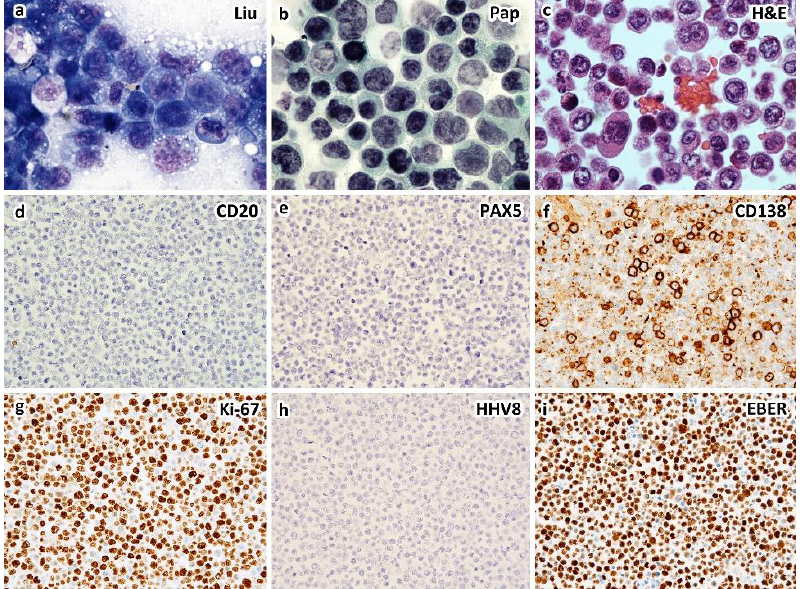
Figure 2 . An example of HIV-unrelated, HHV8-negative (type II) PEL of plasmablastic type in a 61-year-old man who presented with left pleural effusion and ascites without solid tumor by CT scans. Cytological smears of the left pleural effusion and ascites show similar features of large, atypical lymphocytes with anaplastic morphology and intracytoplasmic vacuoles by Liu stain ( a ) and Papanicolaou stain ( b ). Cell block section shows large, atypical lymphocytes with occasional Hodgkin/Reed– Sternberg-like cells (( c ), H&E stain). Immunohistochemically, the atypical lymphocytes express CD138 ( f ), EMA and IRF4/MUM1, but not CD3, CD19, CD20 ( d ), CD30, CD45, CD56, CD79a, PAX5 ( e ), HHV8-LANA1 ( h ), kappa, or lambda light chains. Ki-67 proliferation index is greater than 90% ( g ). EBER in situ hybridization is positive ( i ). Interphase fluorescence in situ hybridization reveals rearrangements of BCL2 and MYC, but not BCL6. Serum HIV assay is negative (( a – c ), × 1000; ( d – i ), × 400 magnification).